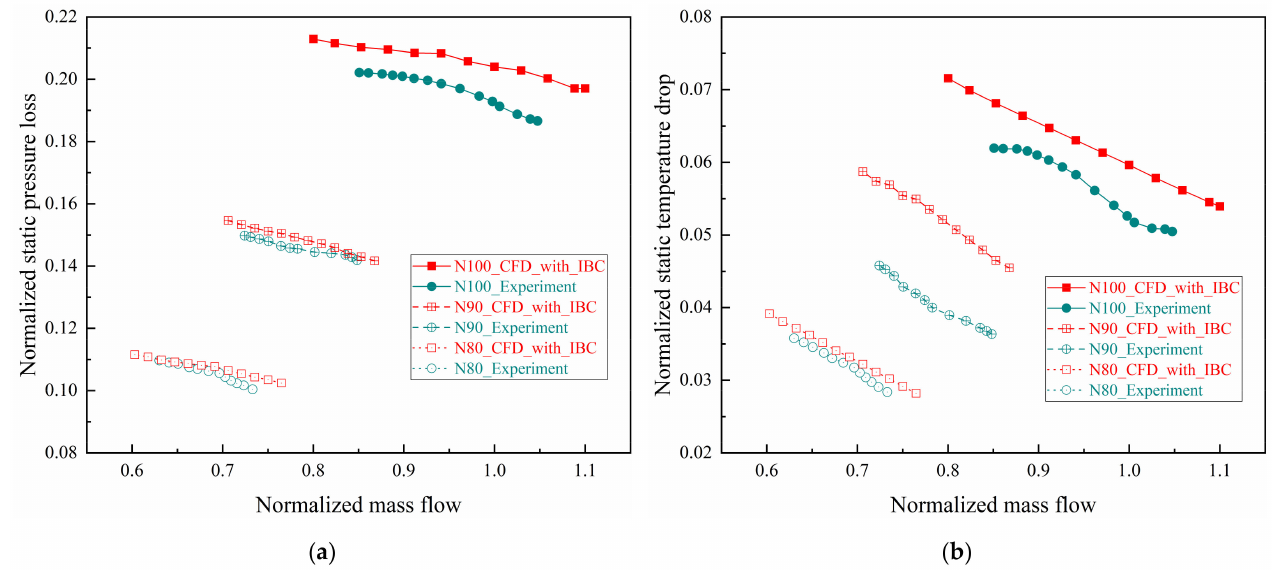
Figure 14. Predicted and measured radial p s loss and T s drop of IBC under variable rotating speeds: ( a ) static pressure loss; ( b ) static temperature